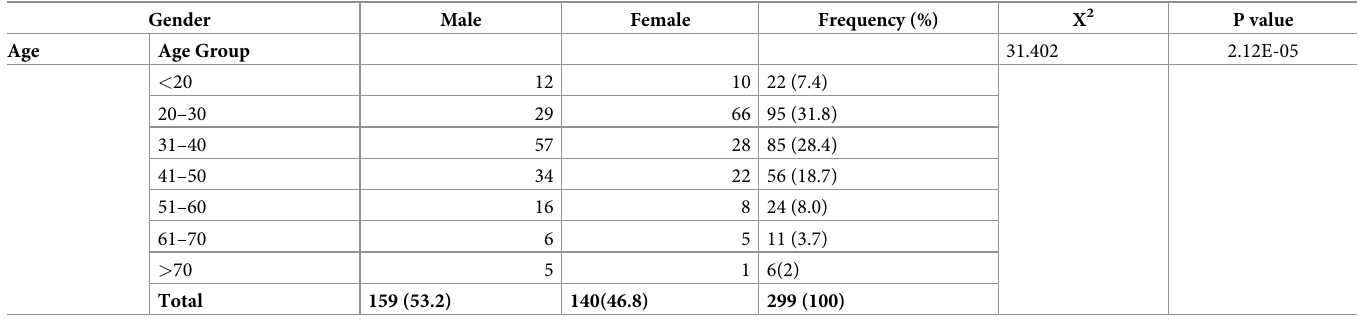
Table 1. Age and sex distribution of study participants (n = 299).